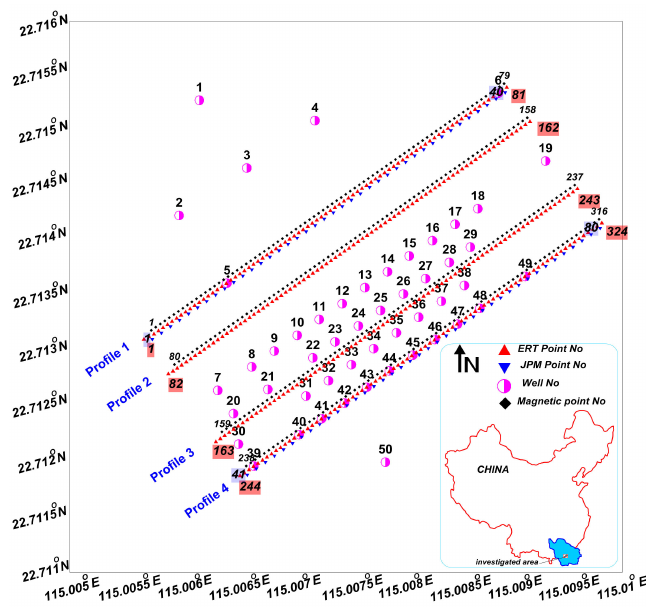
Figure 1. Location map of the study